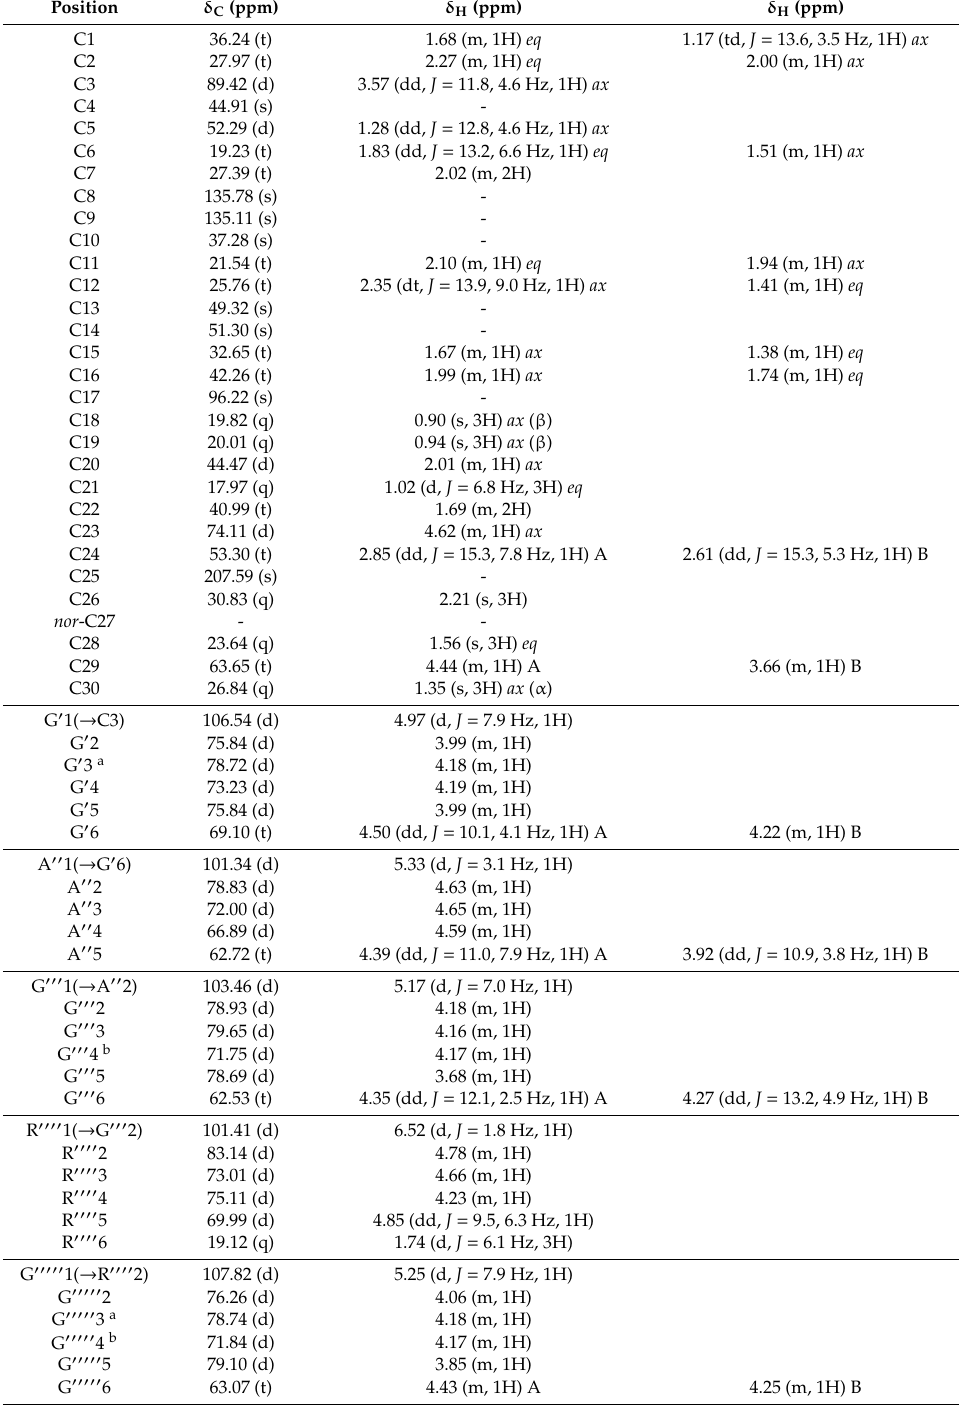
Table 1. 1 H-(600 MHz) and 13 C-(125 MHz) NMR chemical shifts of compound 12 (in pyridine- d5 ).